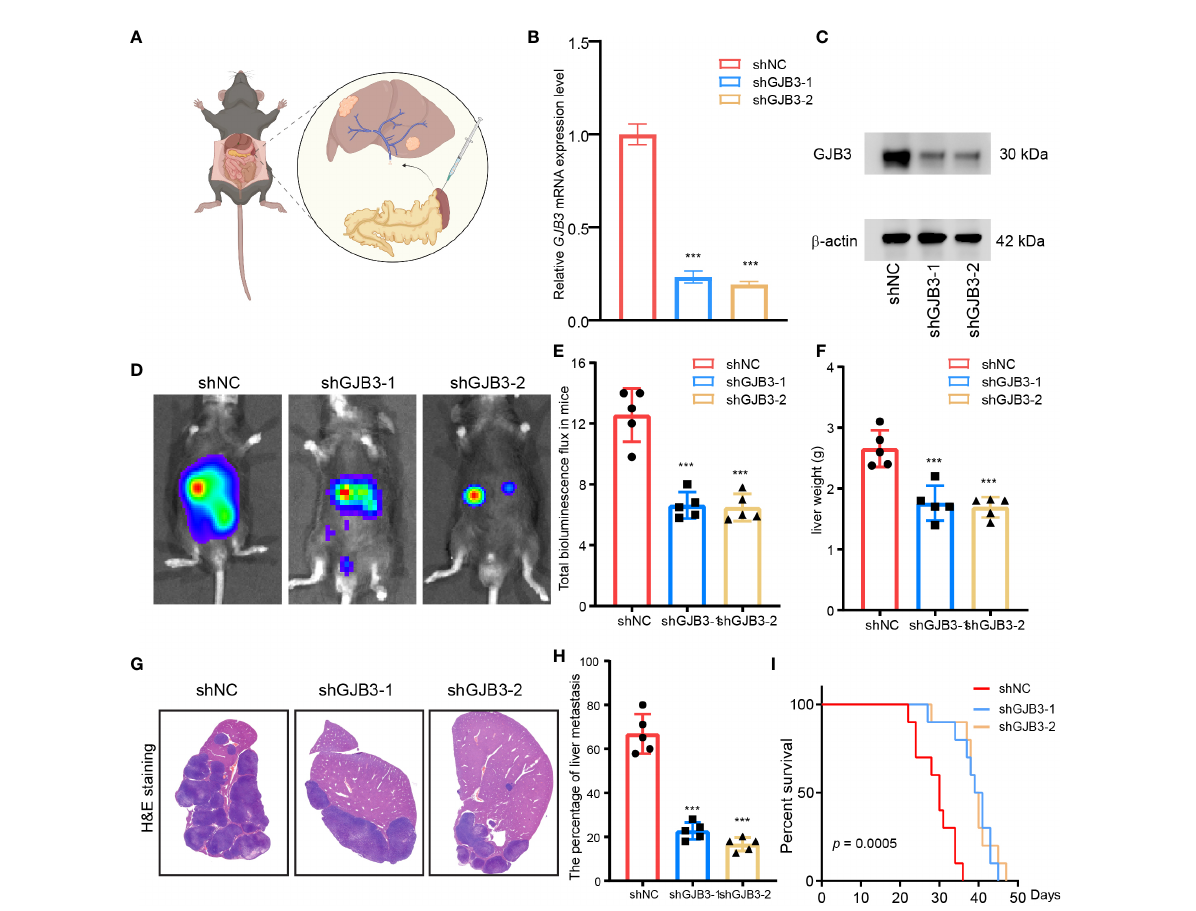
FIGURE 2 GJB3 depletion suppressed PDAC liver metastasis in mice model (A) . Schematic diagram of PDAC mice liver metastasis model. (B) . The relative GJB3 mRNA expression level in shNC, shGJB3-1 and shGJB3-2 KPC1199 cells. (C) . The immunoblots of GJB3 in shNC, shGJB3-1 and shGJB3-2 KPC1199 cells. (D) . The Bioluminescence imaging of shNC, shGJB3-1 and shGJB3-2 KPC1199 cells generated liver metastasis. (E) . The total bioluminescence total fl ux of shNC, shGJB3-1 and shGJB3-2 group mice (n = 5). (F) . The measurement of liver weight derived from shNC, shGJB3-1 and shGJB3-2 group mice (n = 5). (G) . The Representative H & E staining of liver in shNC, shGJB3-1 and shGJB3-2 group mice. (H) . The statistical results of the area invaded by PDAC cells. (I) . The overall survival of mice in shNC, shGJB3-1 and shGJB3-2 group (n = 10). Data presented as mean±standard deviation.